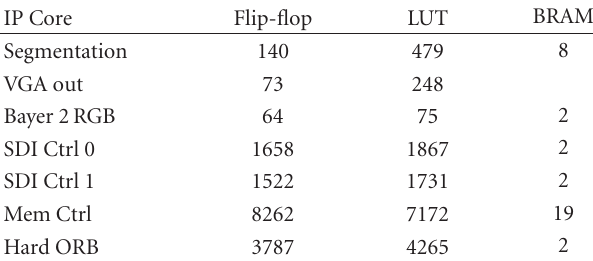
Figure 10: Hardware ORB client and server experiment setup. Table 1: The FPGA resource usage by the SoC